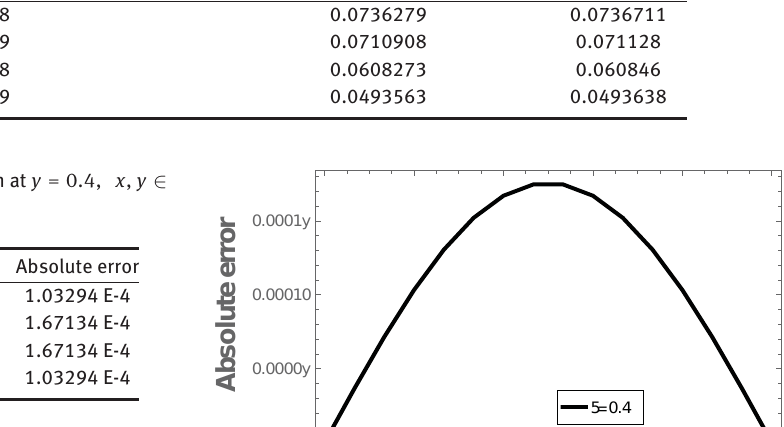
Table 3: U at the centre of the duct. finite difference and analytic simulations compared M x Finite differenc method using a mesh of 50 × 50 [21]